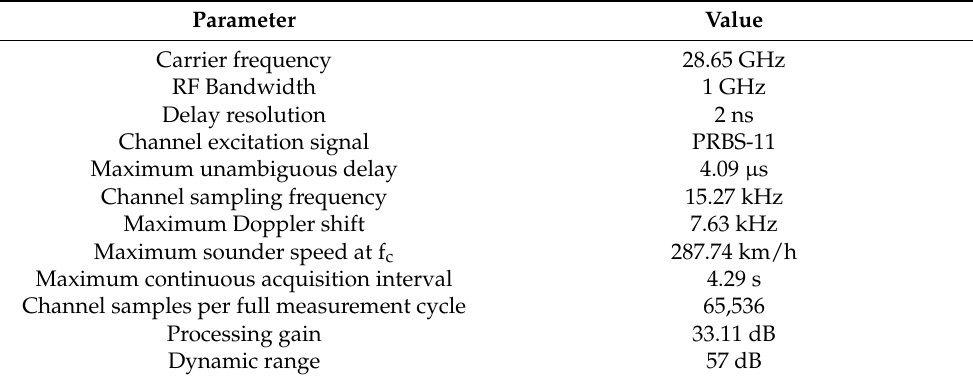
Table 3. Sounder